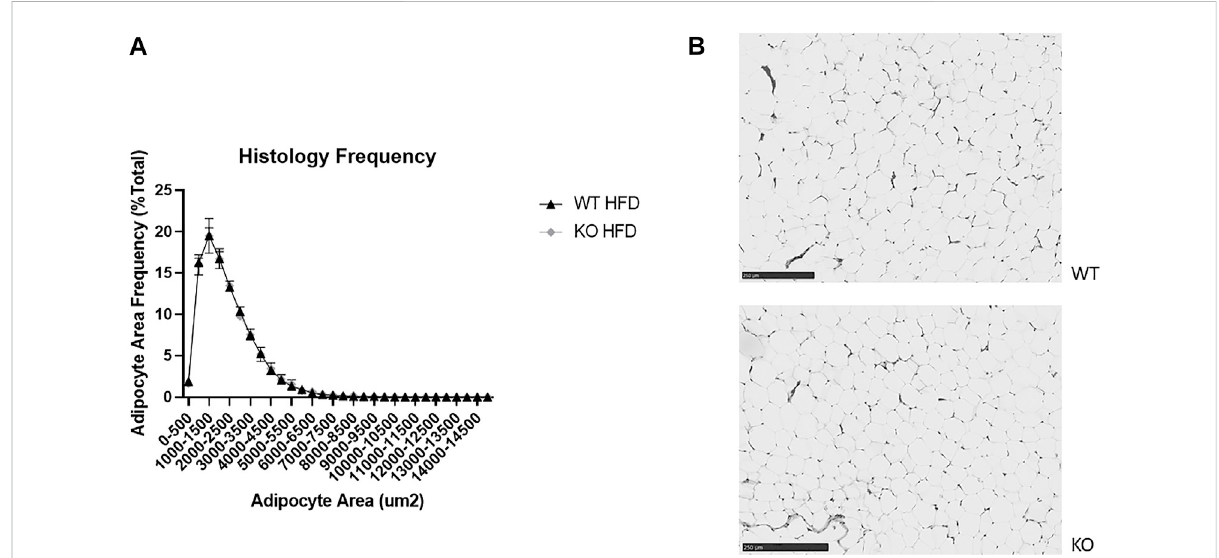
FIGURE 9 Nodifferenceinadipocytesizeornumberbetweenwild-type(WT;black fi lledtriangle)and Krtcap3 knock-out(KO;gray fi lleddiamond)female rats. Sections of retroperitoneal fat (RetroFat) were taken from representative WT and KO females on a high-fat diet (HFD) and stained for hematoxylin and eosin. (A) There were no differences in the frequency distributions of adipocyte area between WT and KO females, as shown by